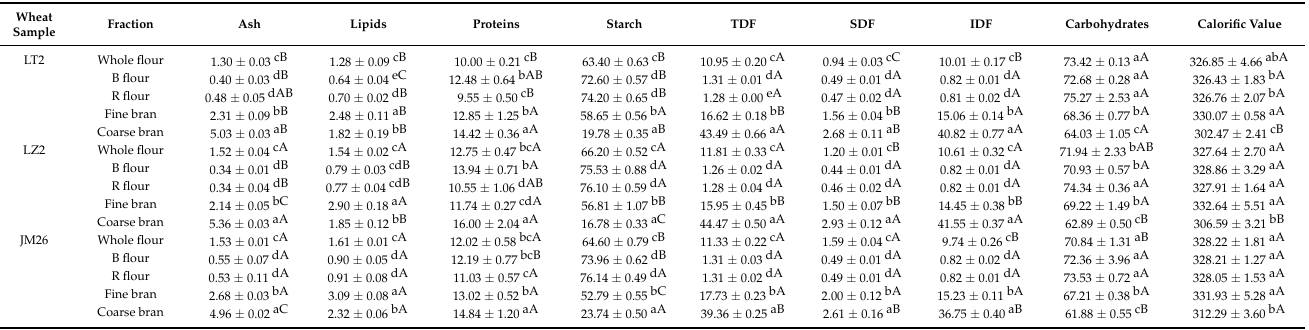
Table 2. Basic chemical composition (g/100 g, with calorific value represented as kcal/100 g) of milling fractions of LT2, LZ2, and